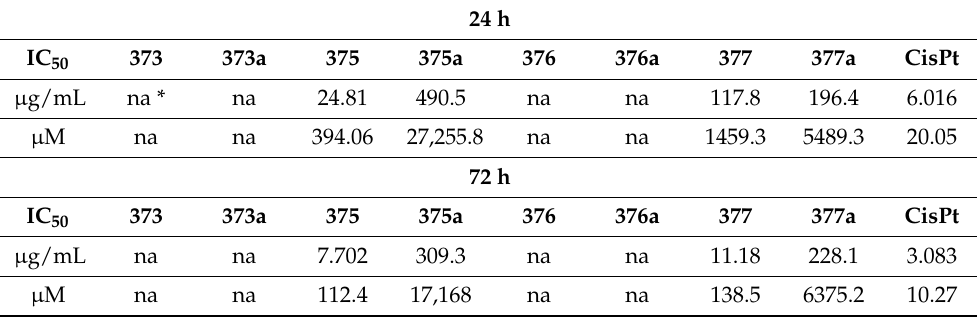
Table 2. Effect of studied NSAIDs and their rhenium derivatives on the viability of HEC-1A cell line after 24- and 72-h treatment; the results were expressed as the mean IC 50 ( µ M; µ g/mL) from three independent experiments;